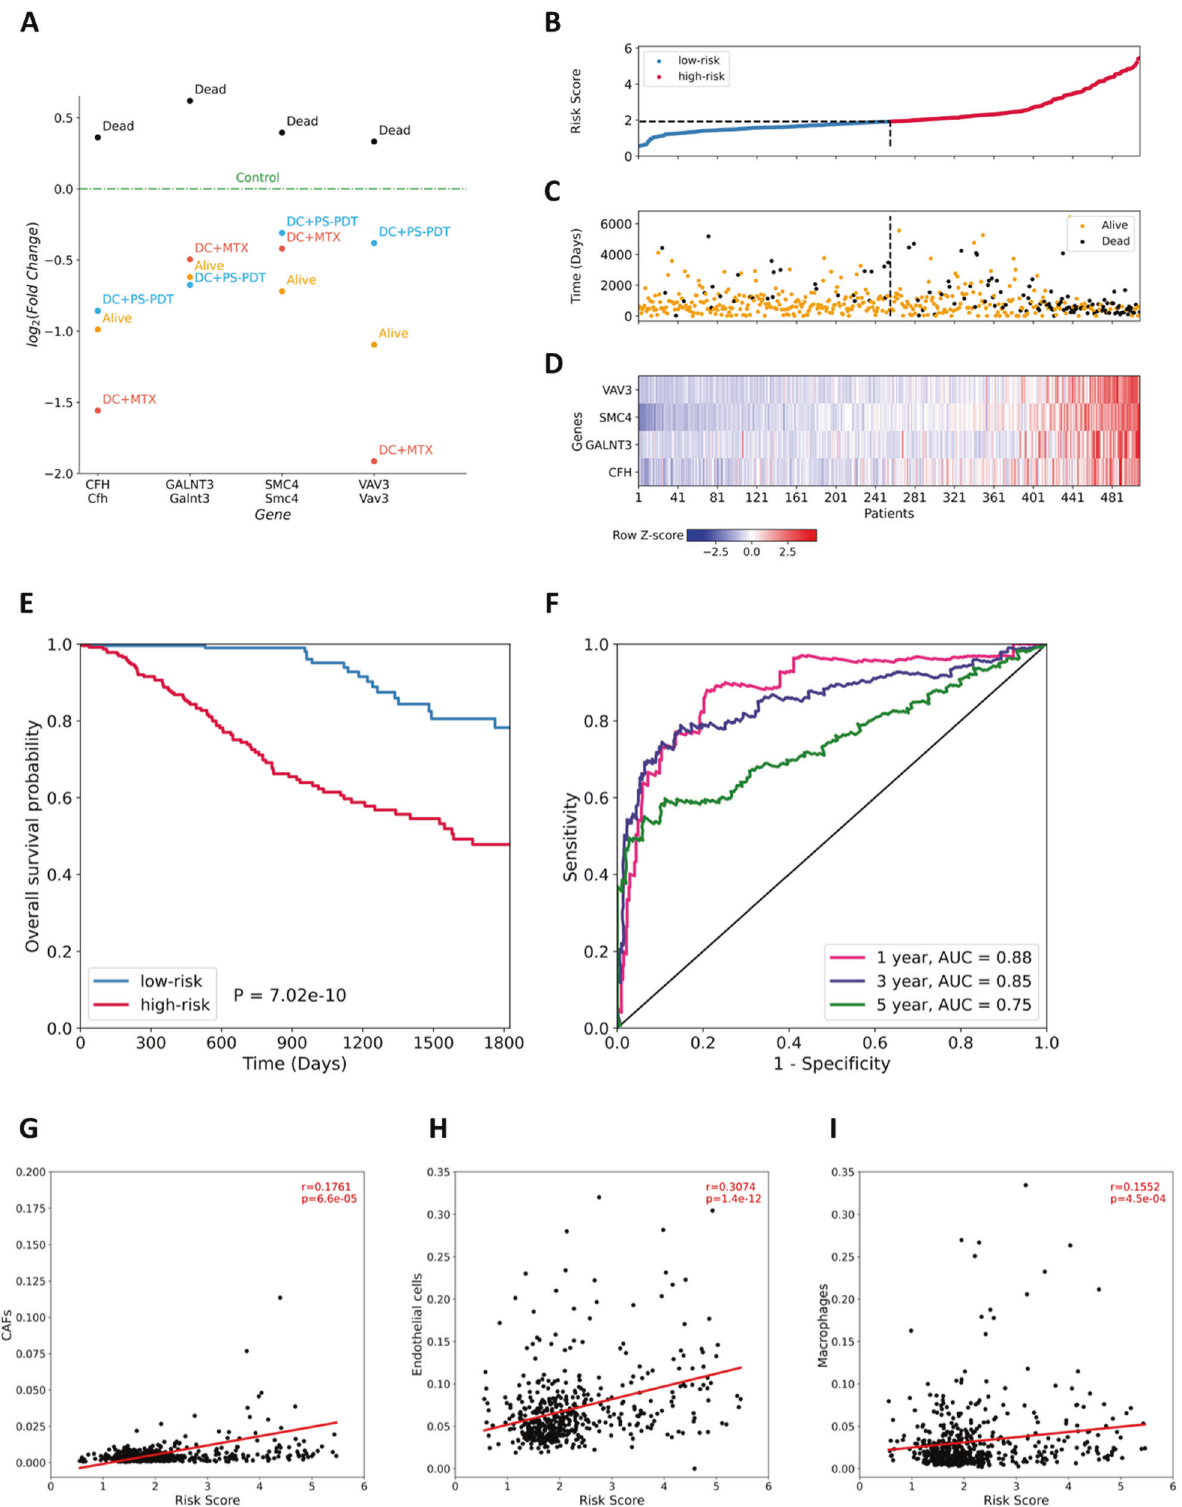
Fig. 6 Four-gene prognostic signature and its relationship with overall survival in the TCGA-LGG dataset. A Plot of log 2 Fold Change expression of the genes from the four-gene prognostic model. For each gene, values of log 2 FC are presented for the DEAD/ALIVE patient groups and for the PS-PDT/MTX groups versus the corresponding control groups. The conditional control level is shown with a green dash- dotted line. B The risk score of each LGG patient. The median risk score for categorizing patients into low-risk (blue) or high-risk (red) groups is 1.92. C The time to death of dead patients (black) and time until last follow-up of live patients (orange). D Heatmap of gene expression pro fi les of the four prognostic genes. E Kaplan – Meier survival analysis of high-risk versus low-risk groups. F Time-dependent receiver operating characteristic curve analysis of the four-gene predictive model. G – I Correlation between the four-gene prognostic signature for TCGA-LGG and the in fi ltration of immune and cancer cell subtypes: CAFs ( G ), endothelial cells ( H ) and macrophages ( I ). Cell Death and Disease (2022)